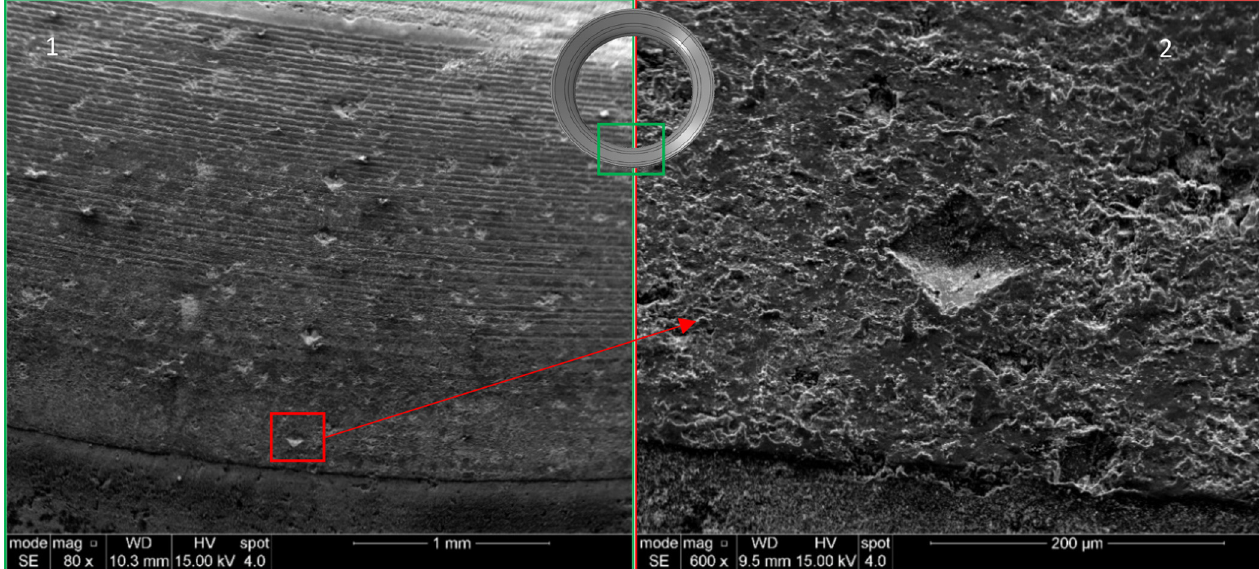
Fig. 27. Seat after 4h test on the “ Cube, 350 ° C, (1) General view of the contact after test, (2) Visualization of the surface marker of the seat in the contact area.